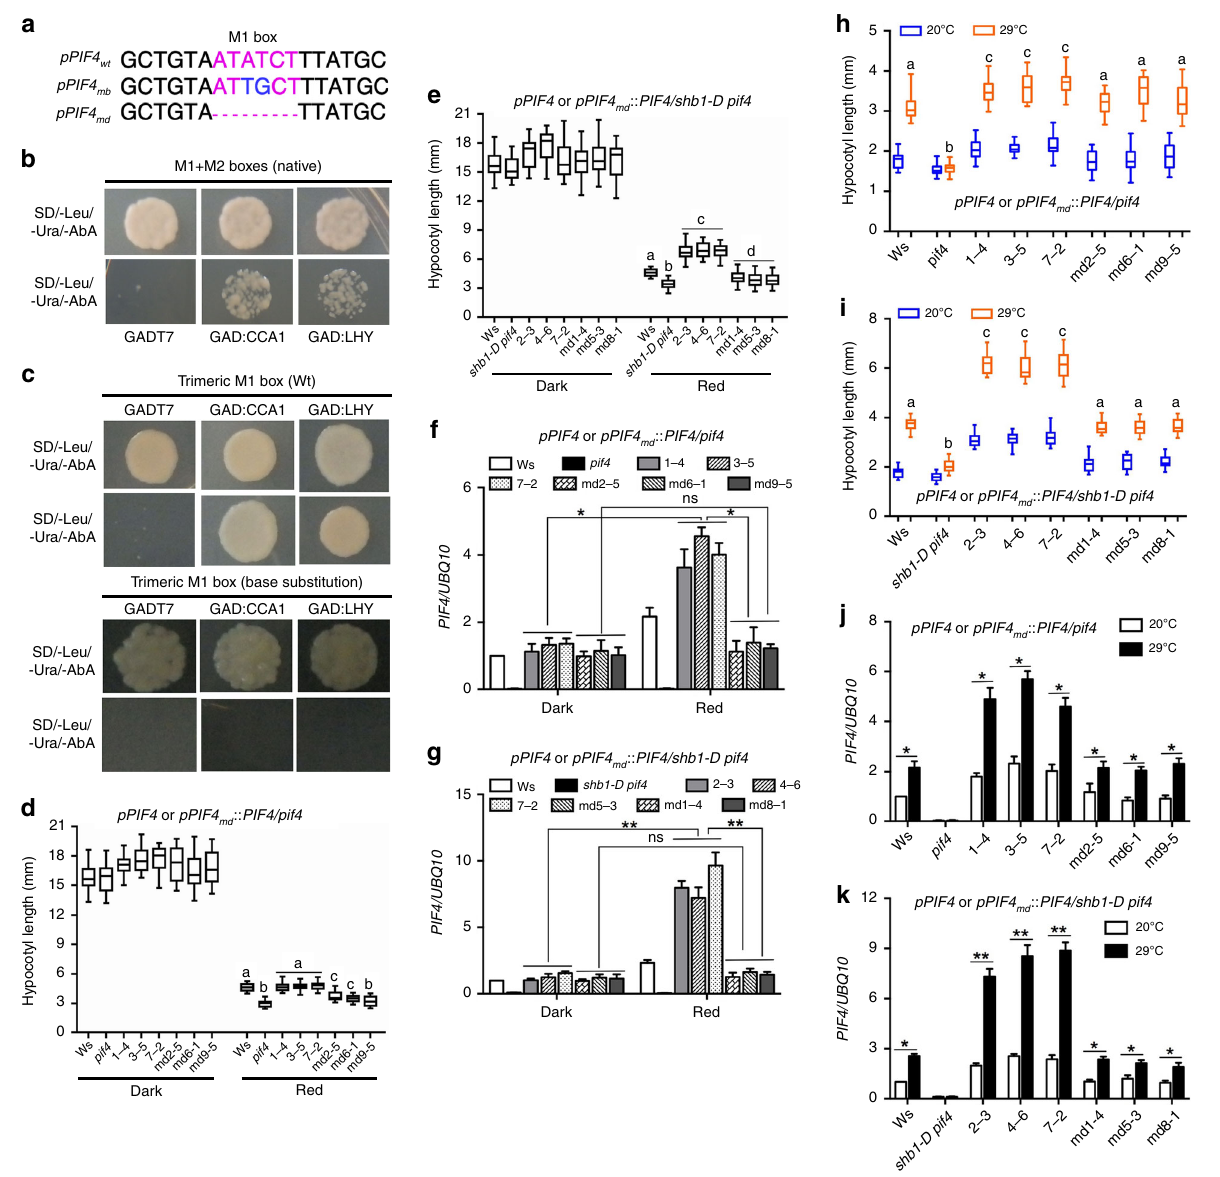
Fig. 5 CCA1 and LHY recognize MYB M1 box in the PIF4 promoter. a Potential MYB-binding element M1 is noted in red, and the bases mutated are noted in blue. mb and md indicate mutation by base substitution and deletion, respectively. Yeast one-hybrid assays for CCA1 or LHY in pGADT7 over a 424-bp fragment that contains both M1 and M2 elements from the PIF4 promoter in the pAbAi vector b and for CCA1 or LHY in pGADT7 over trimeric repeats of wild type (upper) or mutated (lower) M1 element c . Golden Y1H cells were grown on SD/-Leu/-Ura media with or without 300 ng/ml Aureobasidin A (AbA) selection. Hypocotyl lengths of Ws, pif4 and pPIF4 or pPIF4md :: PIF4 in pif4 d and Ws, shb1-D pif4 and pPIF4 or pPIF4md :: PIF4 in shb1-D pif4 e . PIF4 expression in Ws, pif4 and pPIF4 or pPIF4md :: PIF4 in pif4 f and Ws, shb1-D pif4 and pPIF4 or pPIF4md :: PIF4 in shb1-D pif4 g . The seedlings were grown in the dark or under 10 μ mol m − 2 s − 1 red light for 4 days. Hypocotyl lengths of Ws, pif4 and pPIF4 or pPIF4md :: PIF4 in pif4 h and Ws, shb1-D pif4 and pPIF4 or pPIF4md :: PIF4 in shb1-D pif4 i under 30 μ mol m − 2 s − 1 white light at 20 °C for 7 days or 20 °C for 4 days followed by 29 °C for 3 days. PIF4 expression in Ws, pif4 and pPIF4 or pPIF4md :: PIF4 in pif4 j and Ws, shb1-D pif4 and pPIF4 or pPIF4md :: PIF4 in shb1-D pif4 k grown at 20 °C for 5 days and then incubated at 20 °C or 29 °C for 4 h. Signi fi cance levels by Student ’ s two-tailed heteroscedastic t tests in d : p < 0.001 between a and b , p < 0.01 between a and c , p < 0.05 between b and c ; in e : p < 0.001 between a and b , a and c , b and c or c and d , p < 0.01 between a and d , p < 0.05 between b and d ; in h : p < 0.001 between a and b or b and c , p < 0.01 between a and c ; in i : p < 0.001 between a and b , a and c or b and c . Source data are provided as a Source Data fi le